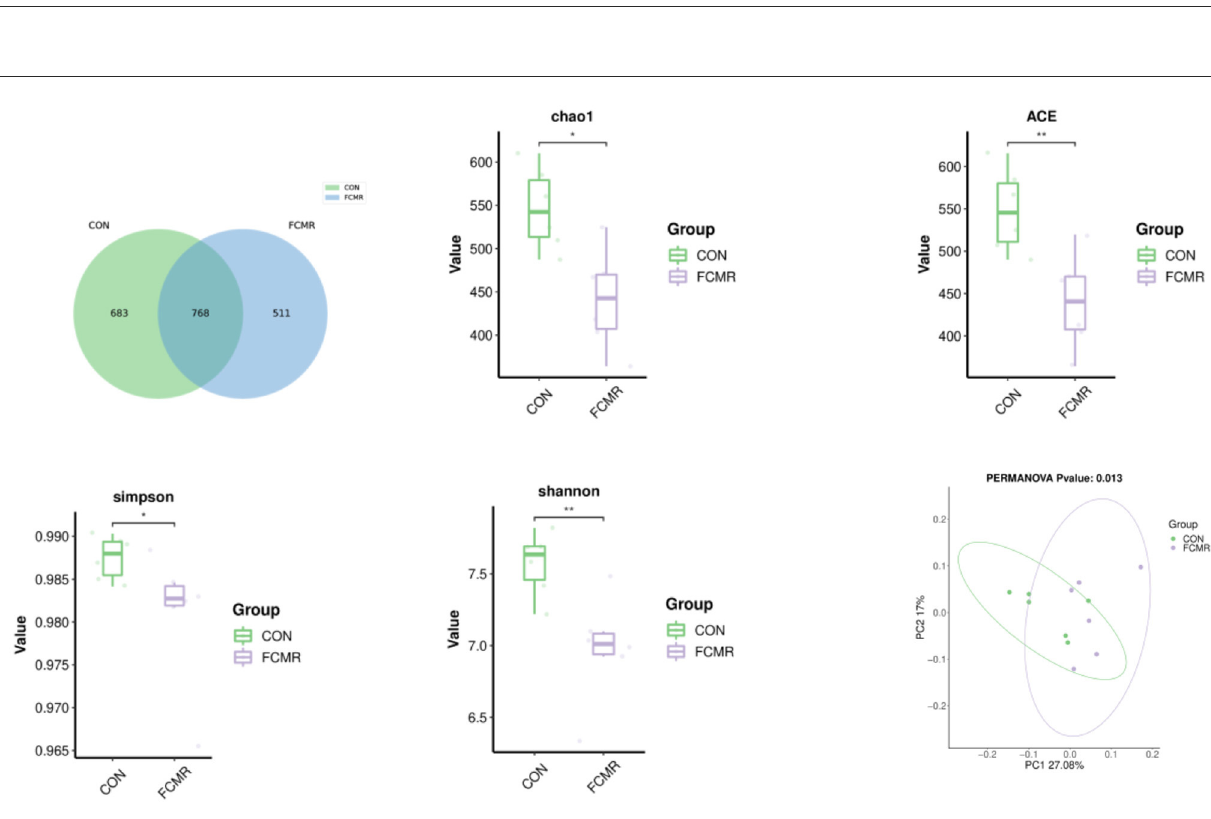
FIGURE3 The effects of FCMR addition to the diet on the Venn diagram, α -diversity, and β -diversity of broiler cecum microorganisms. Principal coordinate analysis (PCoA) calculated based on weighted UniFrac distances from the ASV abundance matrix; *indicates that there is a considerable difference between the two groups (* p < 0.05, ** p <